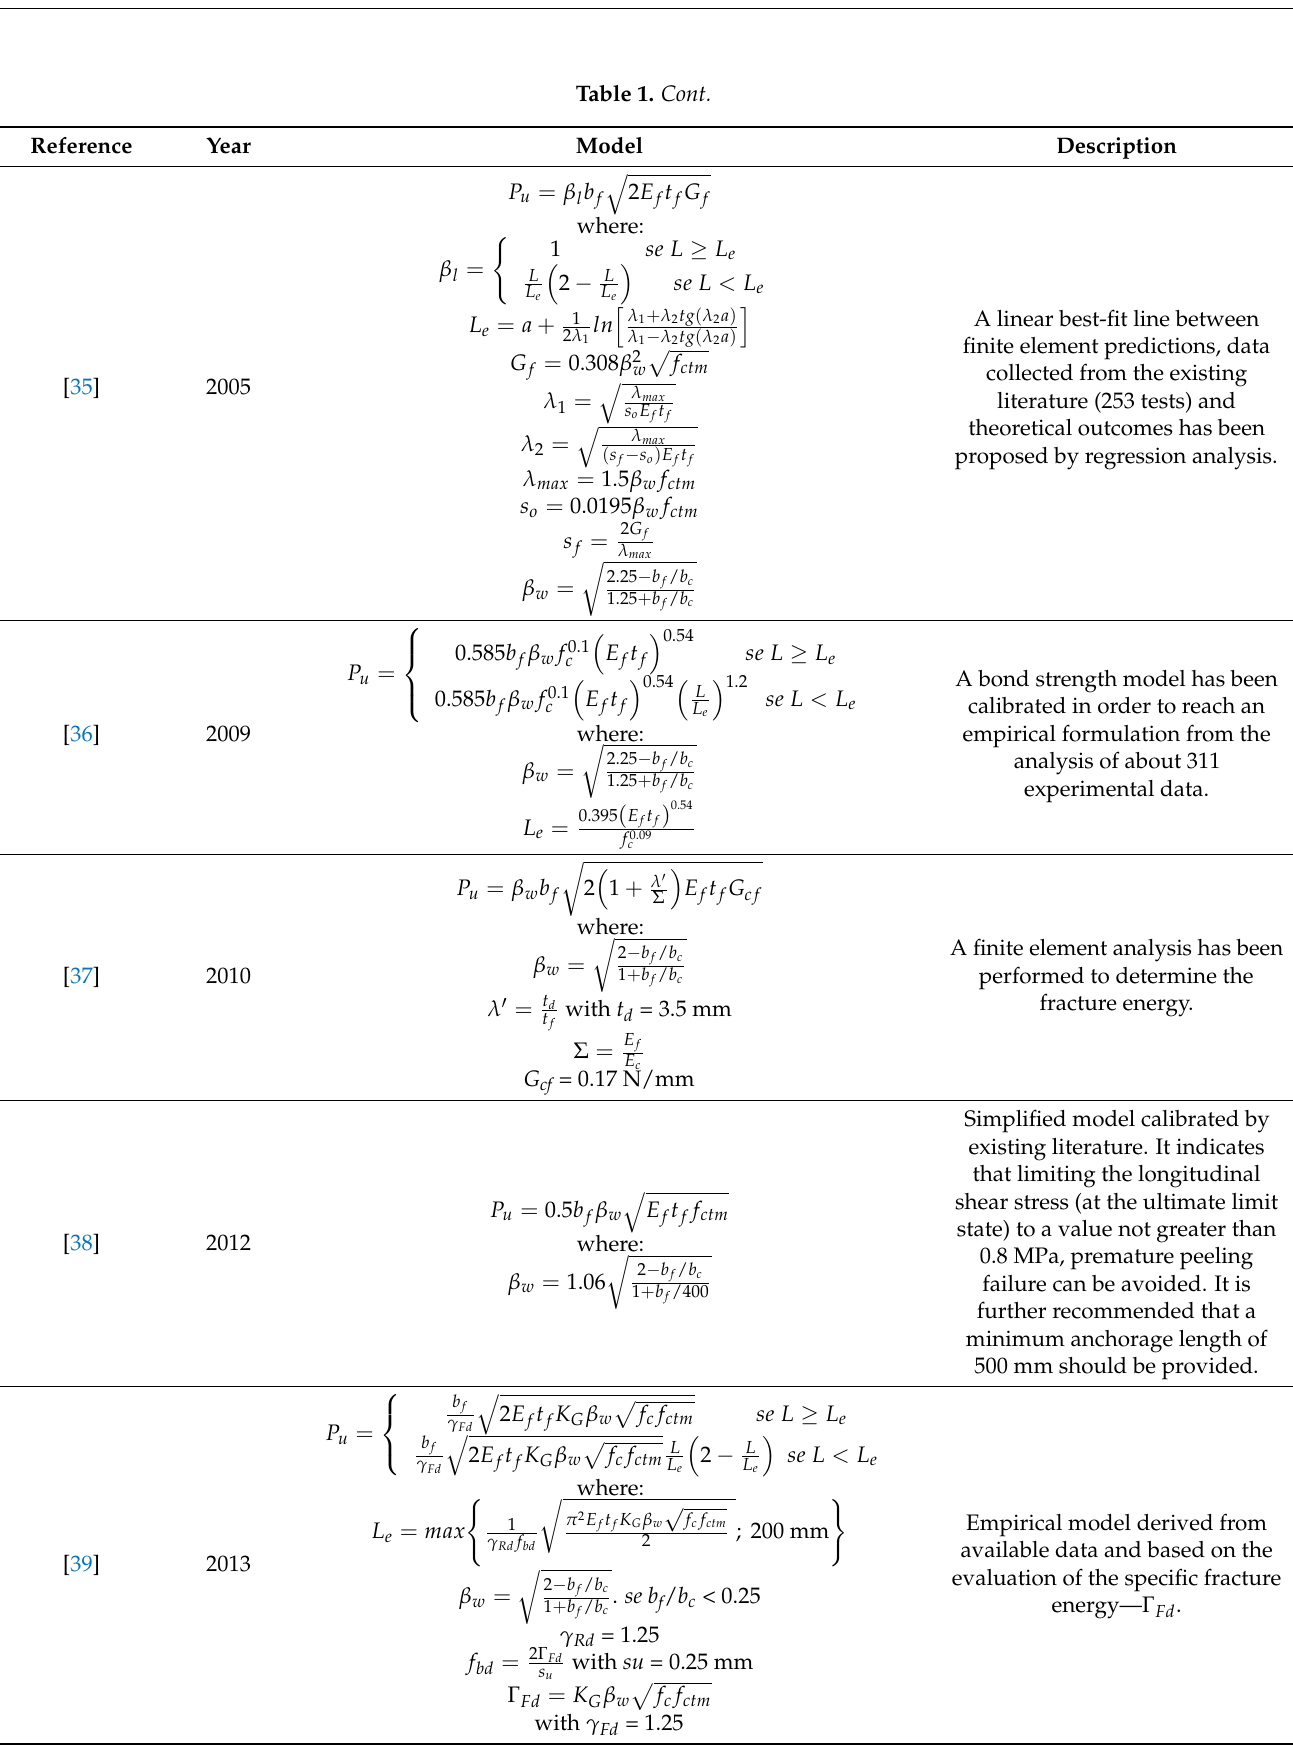
A linear best-fit line between finite element predictions, data literature (253 tests)